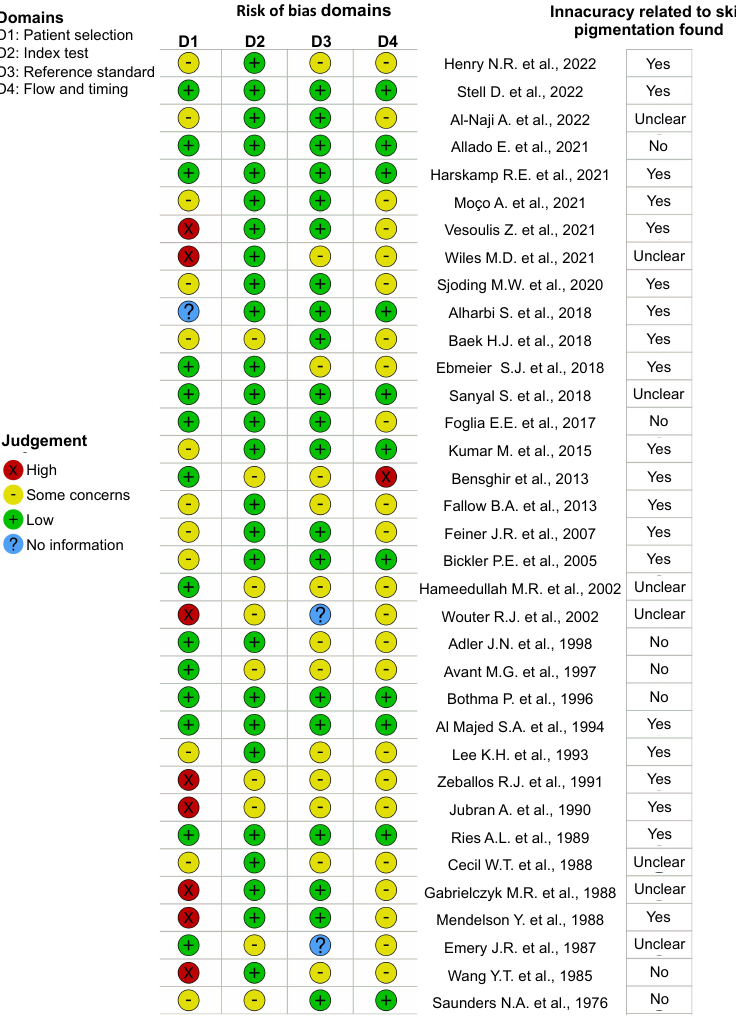
Figure 2. Risk of bias assessment in individual studies judged according QUADAS − 2. The right column shows the qualitative final conclusion reported by the selected studies [17,21,23,30,38,41–48,50,51,53,56, 69–72,75–82,84,87–89,93] regarding the existence of inaccuracy related to skin